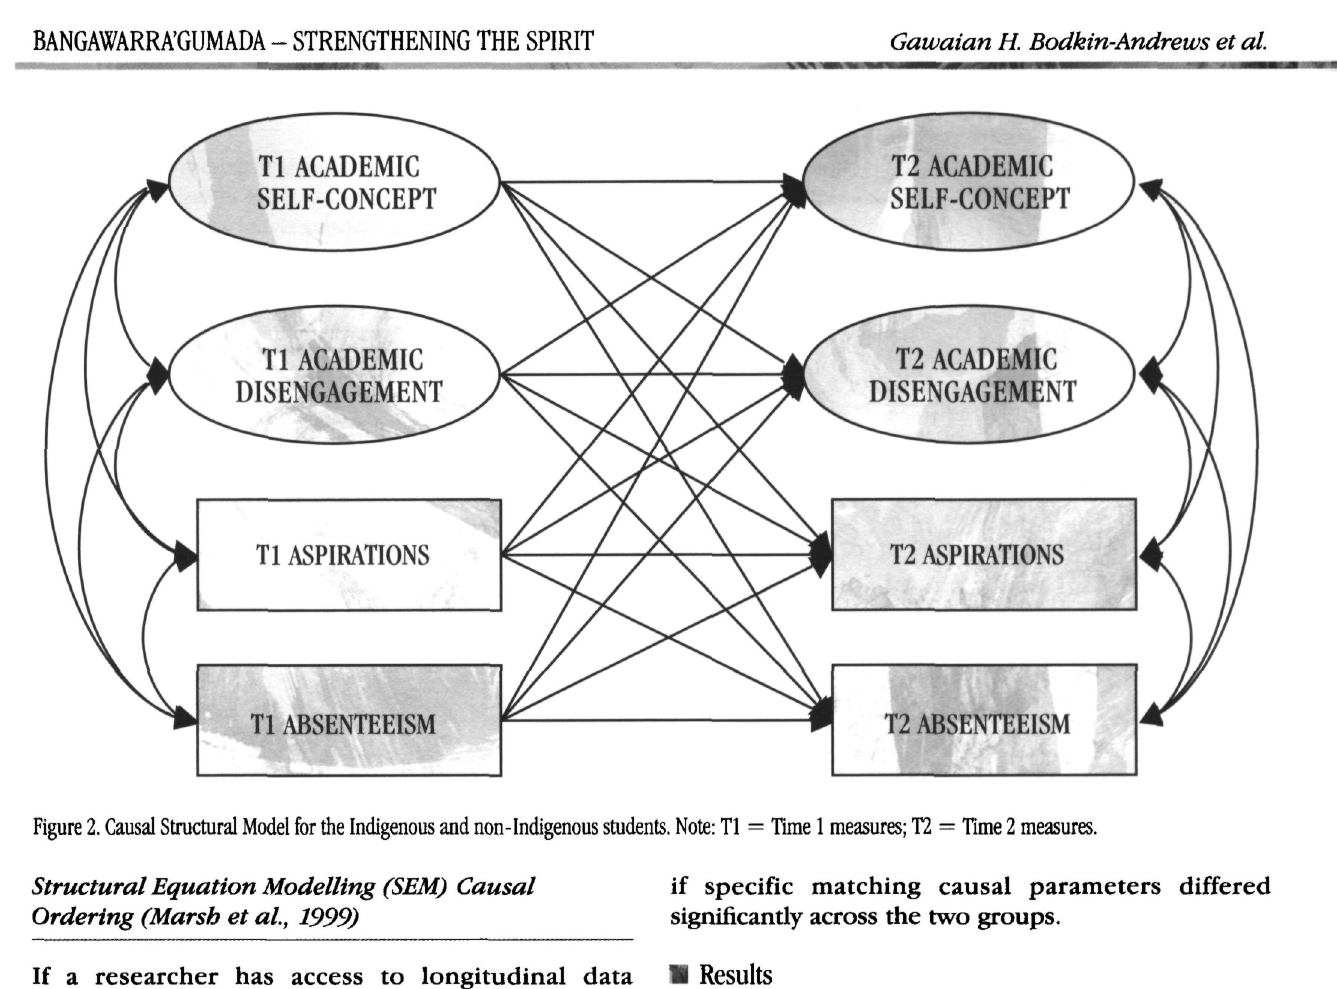
Figure 2. Causal Structural Model for the Indigenous and non-Indigenous students. Note: Tl = Time 1 measures; T2 = Time 2